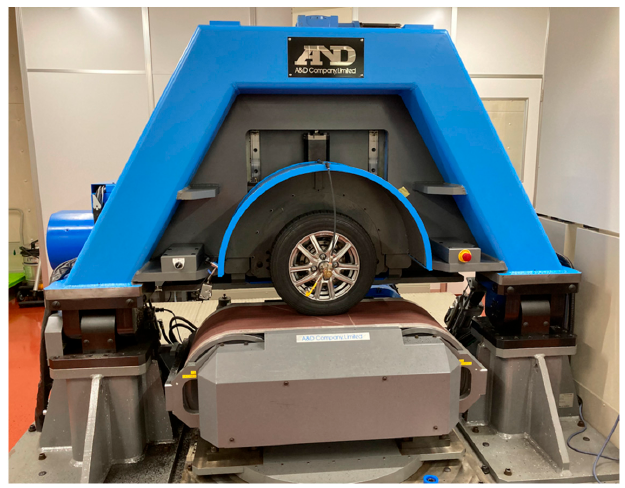
Figure 9. Tire characteristic tester with measurement tire.